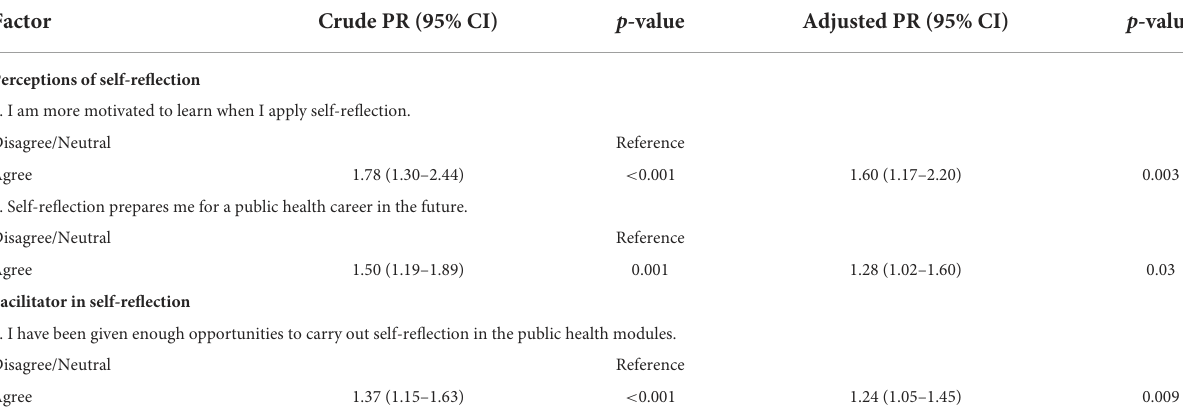
TABLE 3 Crude and adjusted prevalence ratio (PR) of correlates of self-reflection frequency in public health modules. Factor Crude PR (95% CI)